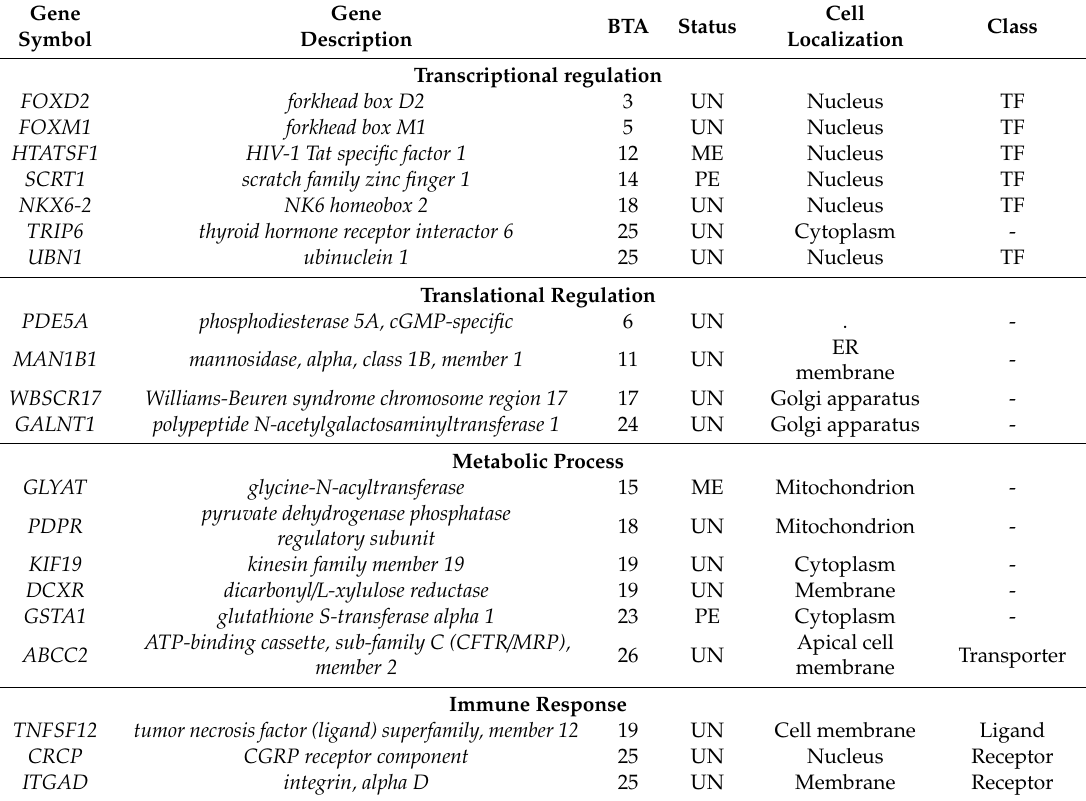
Table 2. Functional annotations of MAE genes based on PathwayStudio